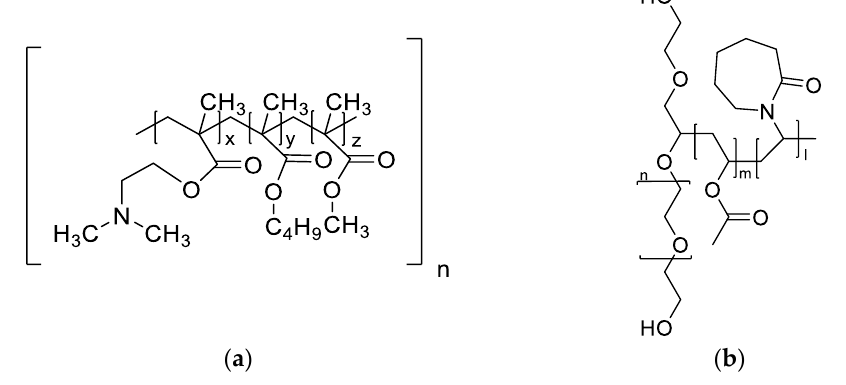
Figure 10. Structural formulas of bPMMA ( a ) and SOL ( b ) [41,45].